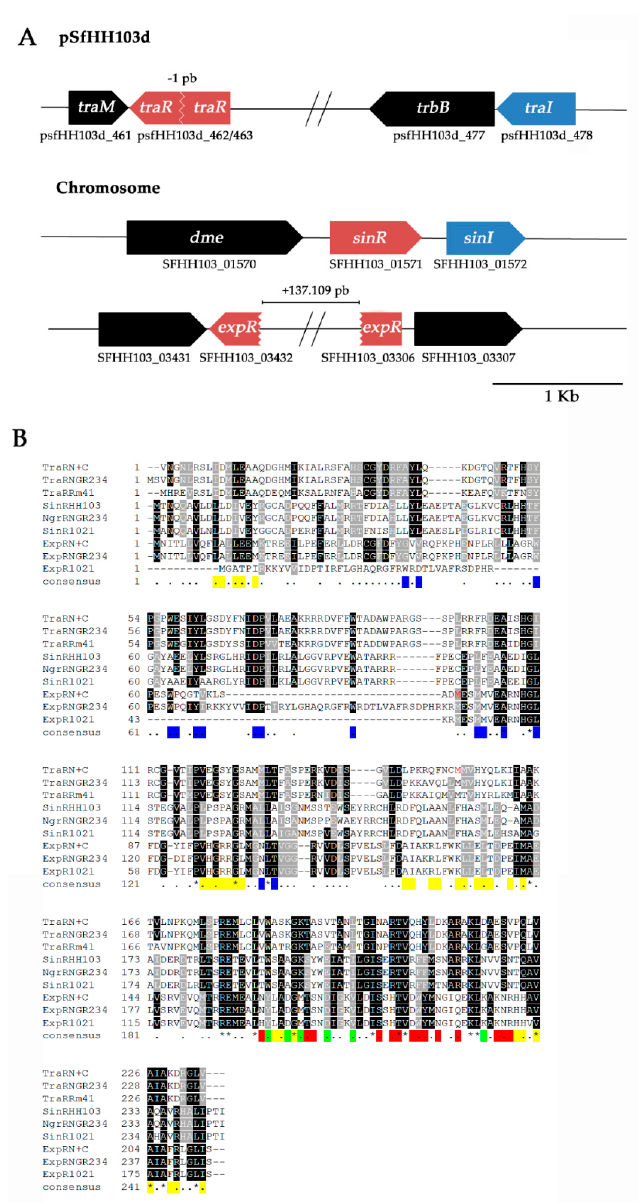
Figure 2. ( A ) Gene neighborhood of the Sinorhizobium fredii HH103 QS genes. In blue luxI homologous genes. In red: luxR homologous genes. Genomic distance between the psfHH103_463 and psfHH103_462 ORFs is − 1 pb (these genes overlap in one nucleotide), whereas between SFHH103_03432 and SFHH103_03306 genes the distance is 137.109 pb. ( B ) Multiple sequence alignment of nine LuxR homologues (reconstructed TraR from Sinorhizobium fredii HH103, TraR from S. fredii NGR234, TraR from Sinorhizobium meliloti Rm41, SinR from S. fredii HH103, NgrR from S. fredii NGR234, SinR from S. meliloti 1021, reconstructed ExpR from S. fredii HH103, ExpR from S. fredii NGR234 and ExpR from S. meliloti 1021). Proteins were aligned using the ClustalW program and manipulated with Boxshade at EMBnet. Dark and gray boxes indicate identical and similar amino acids, respectively. First residue of the C-terminal domains of the reconstructed proteins are in red. Residues functions have been calculated according to those determined for the TraR protein of A. tumefaciens [59]: Residues interacting with AHL and with DNA fragments are marked in the consensus line with blue and red, respectively; residues interacting with RNA polymerase are indicated by green in the consensus line; residues in contact at the dimer interface are marked in yellow in the consensus